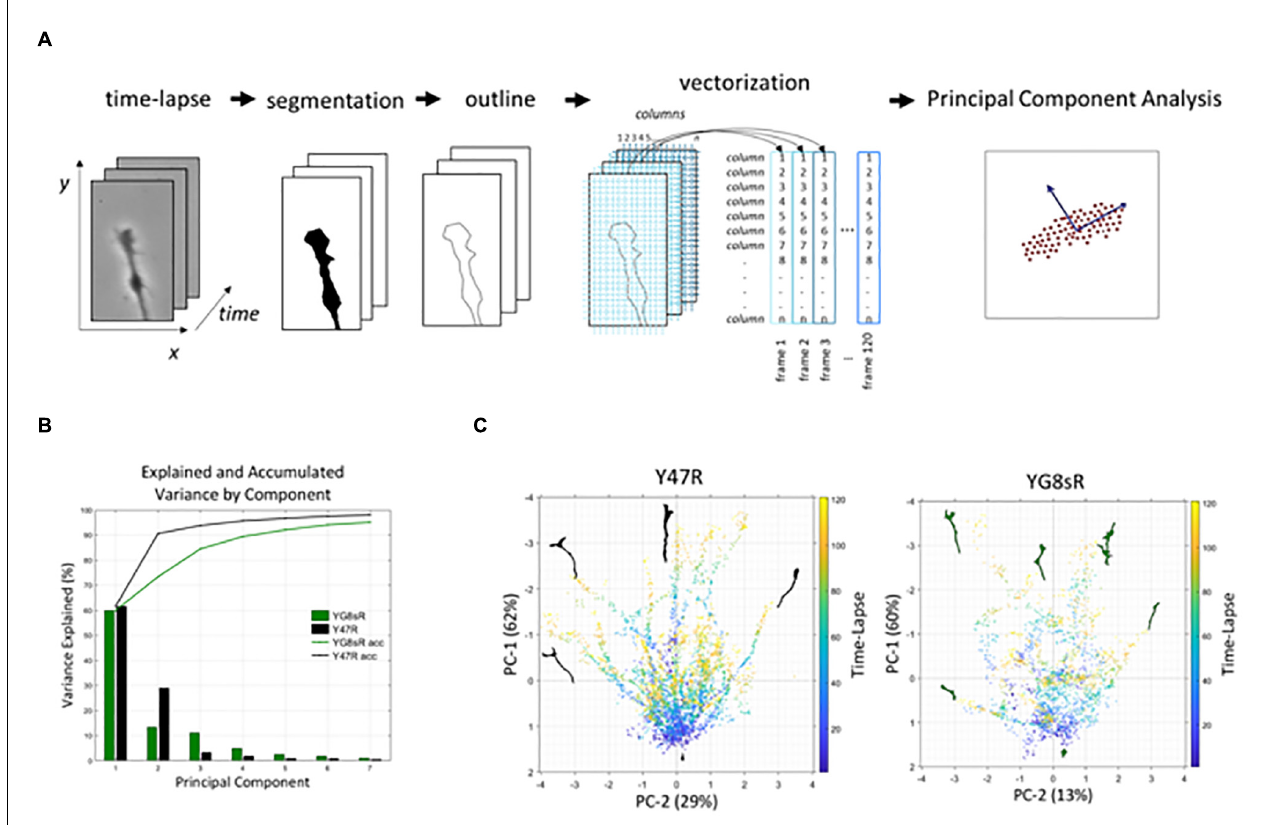
FIGURE 3 | The PCA analysis shows that YG8sR growth cones have a reduced dynamic morphology at 2 months of age. (A) Workflow used for the principal component analysis. (B) The principal component analysis showed that components 1 and 2 explain 91 and 73% of the variance for the control and YG8sR GCs, respectively. (C) Bi-plots of components 1 and 2 visualizing the movement of the growth cone for 1 h. The principal components indicate the main patterns of movement of all points that form the growth cone, including the axonal segment that the growth cone builds over the time-lapse. The lines start in the lower central part of the images (initial position of the cones at t = 0) and are directed to the right, left or above in the images with different angles (final position of the cones at t = 60 min). Therefore, the more dispersed the points are in the graphs, there are fewer trajectories of movement. The length of each trajectory indicates the distance traveled by the growth cones in the time-lapse. When compared to the controls, the YG8sR-growth cones exhibited fewer trajectories and traveled short distances. Besides, the trajectories of the YG8sR-growth cones are less defined and more